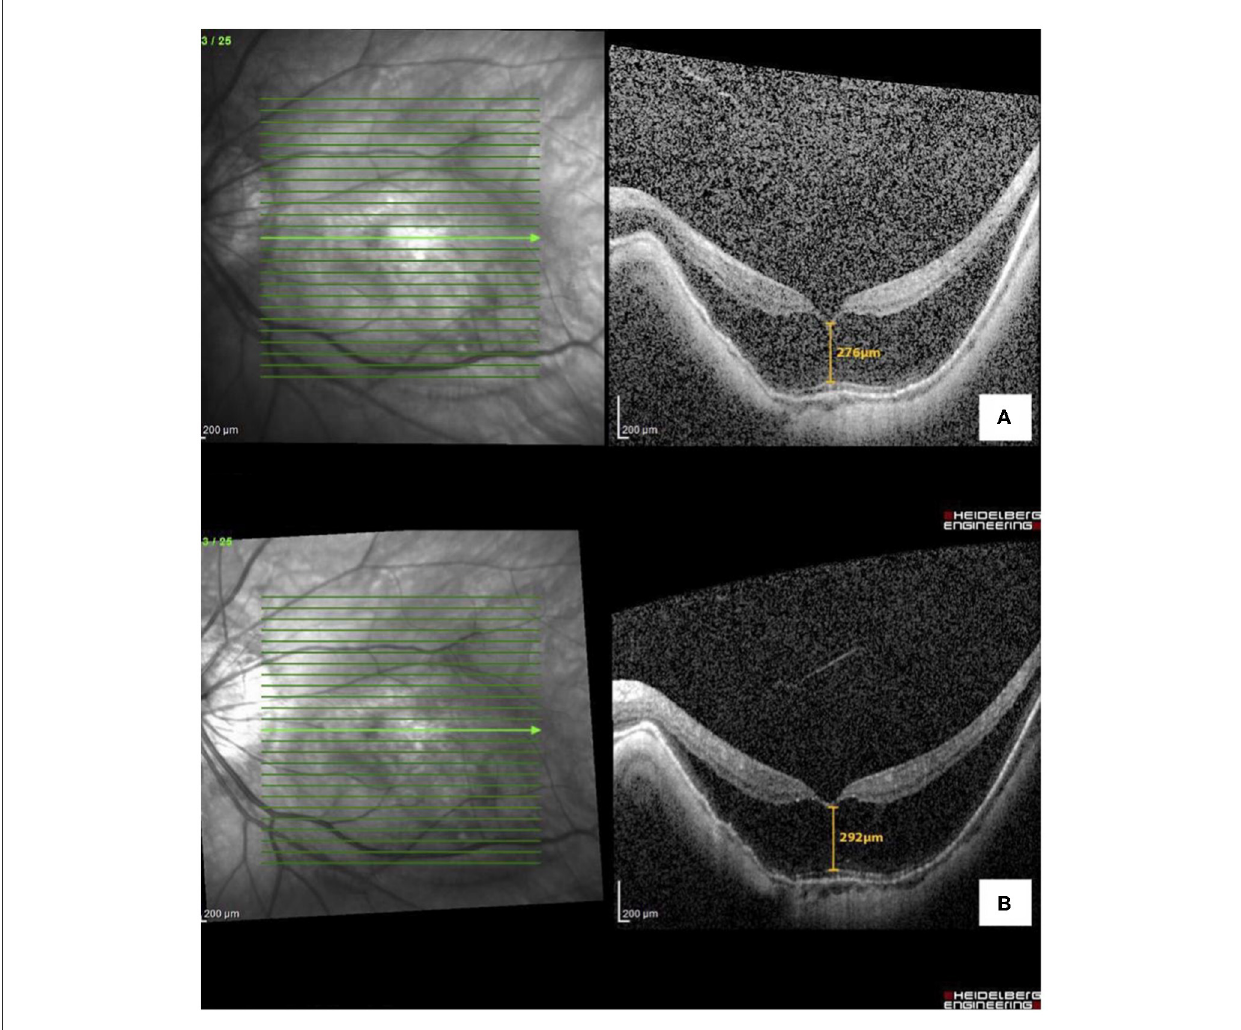
FIGURE2 Optical coherence tomography macula of the left eye with (A) myopic foveoschisis pre-operatively and (B) stable myopic foveoschisis post-cataract